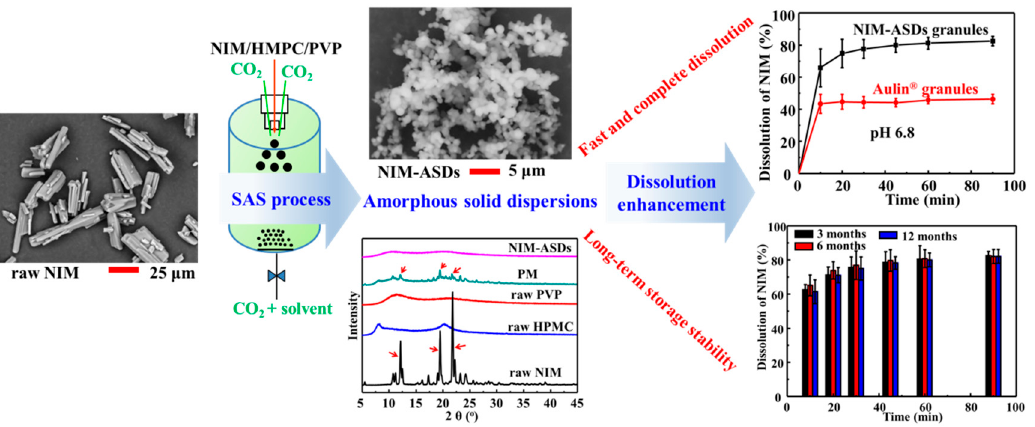
Figure 5. Nimesulide amorphous solid dispersions produced by SAS process. Reproduced with permission from [32], Elsevier, 2020.